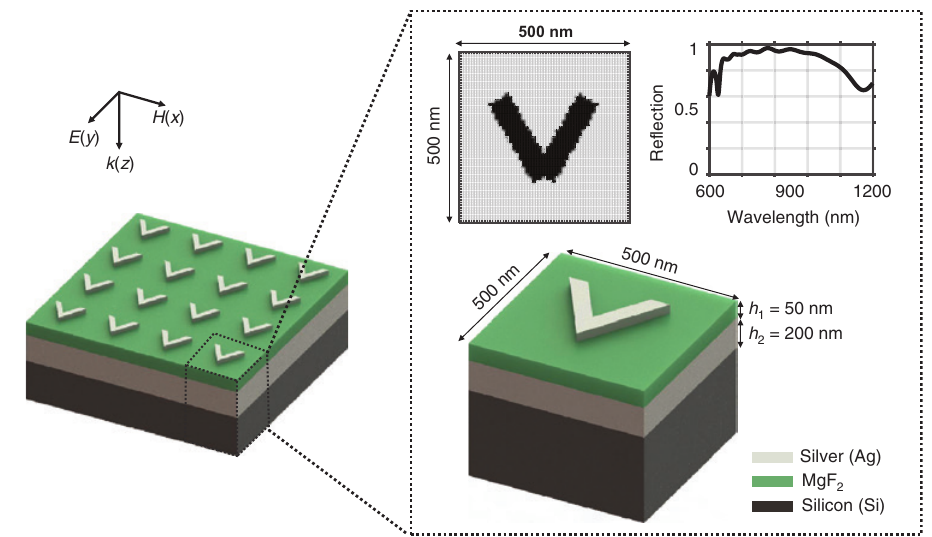
Figure 1: Schematic of data preparation for deep learning. Each entry in the dataset is composed of the reflection spectrum obtained from FDTD simulation and its corresponding cross-sectional structural